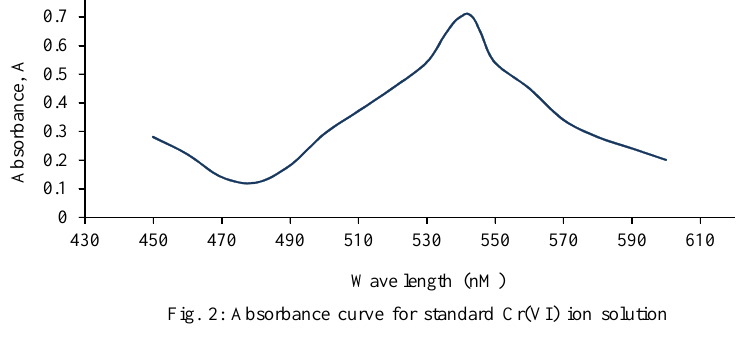
Fig. 2: Absorbance curve for standard Cr(VI) ion solution